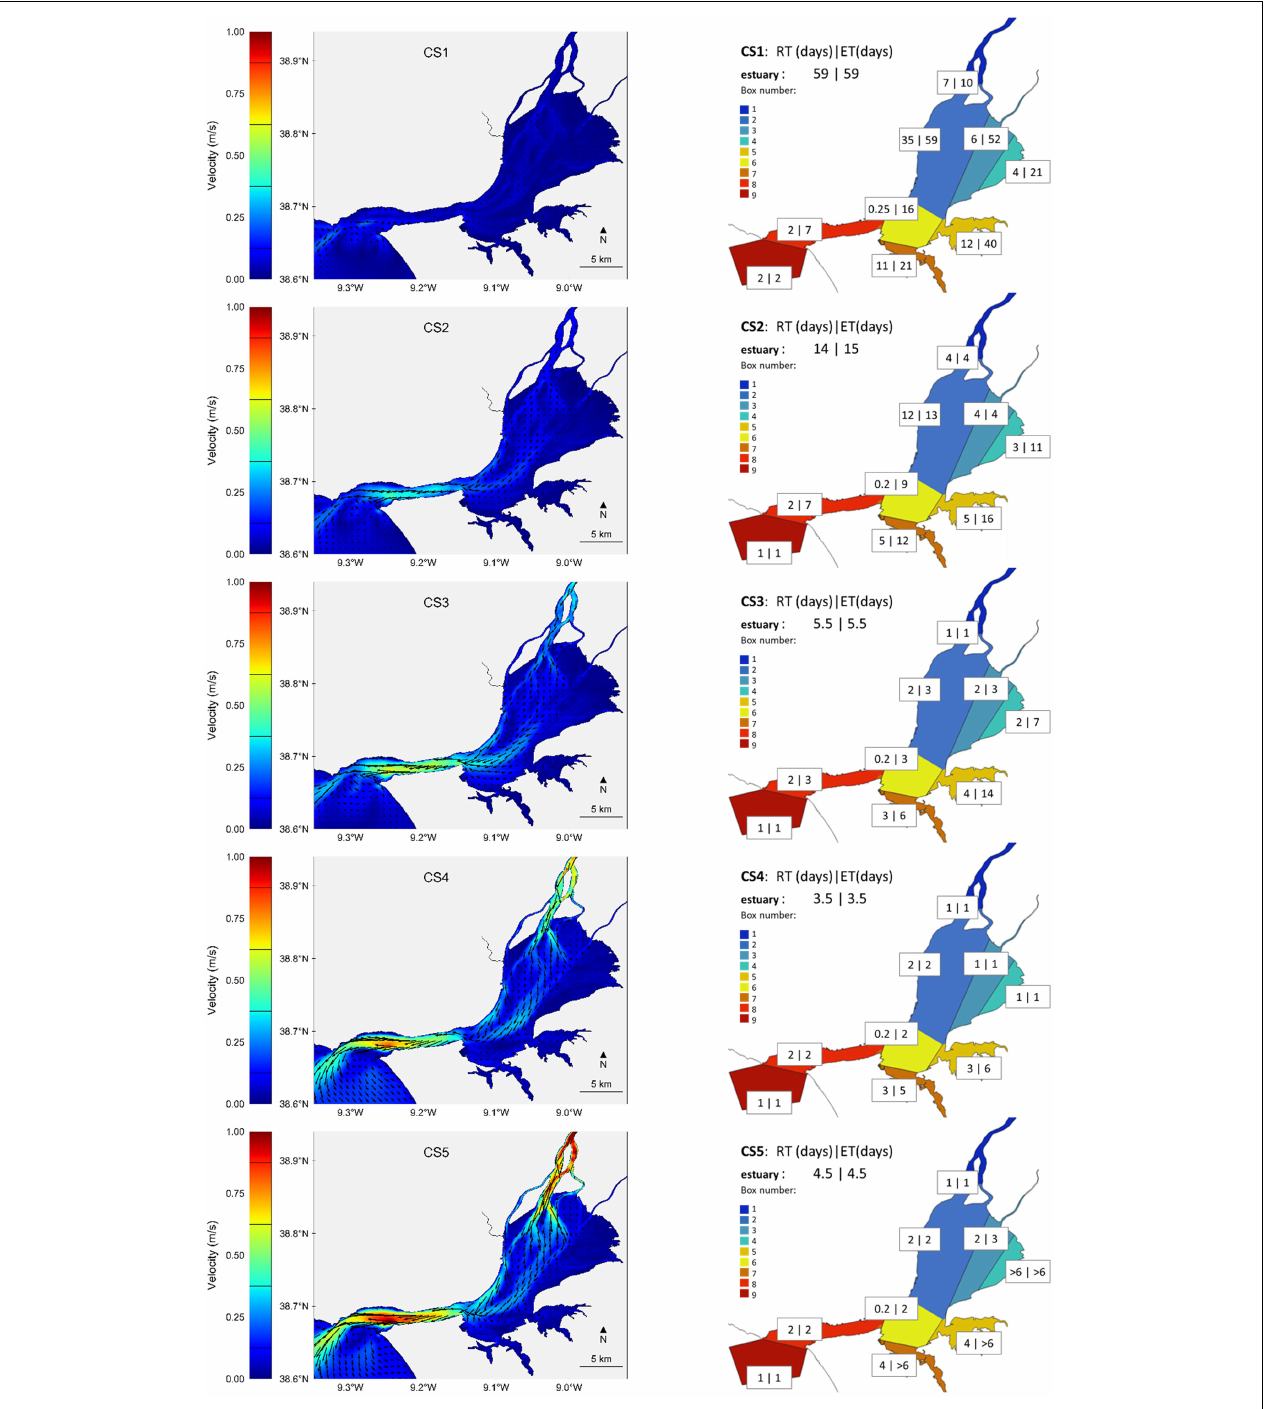
FIGURE 5 | Left: Mean velocity, intensity and direction of the currents in the Tagus estuary for each case study; Right: RT and ET determined for each box and case study.